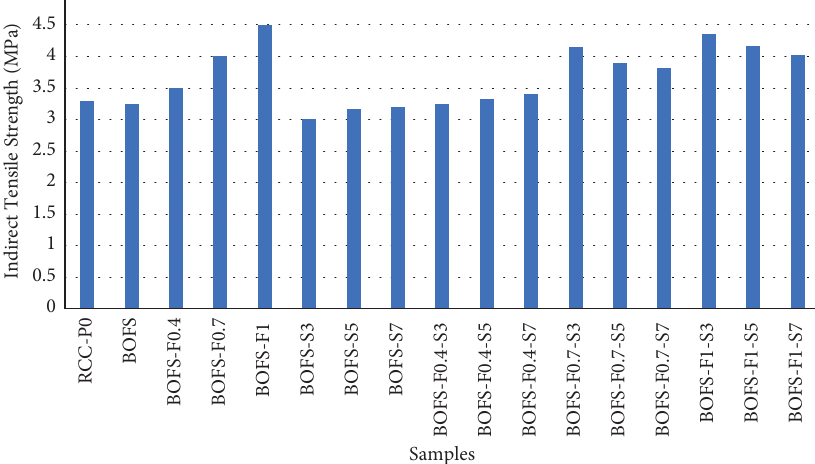
Figure 8: Split tensile strength of 28days cured specimens.